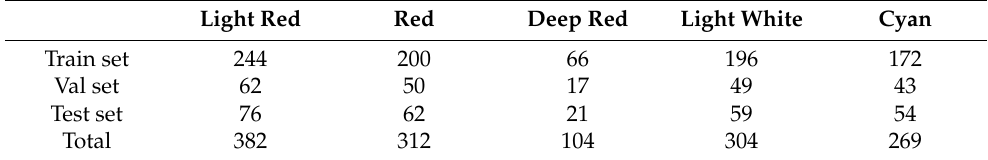
Table 3. Division situation.